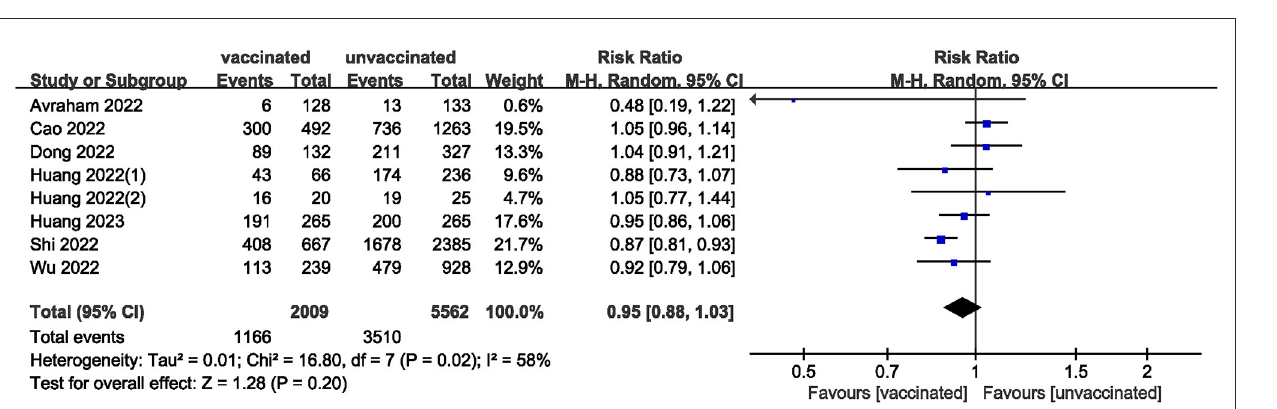
The funnel plot of the studies included in the clinical pregnancy rate was roughly symmetric, with an Egger value of 0.968 (Figure 10). There was no publication bias in ongoing pregnancy rate, biochemical pregnancy rate, blastocysts rate, implantation rate and fertilization rate, with Egger values of 0.718, 0.886,